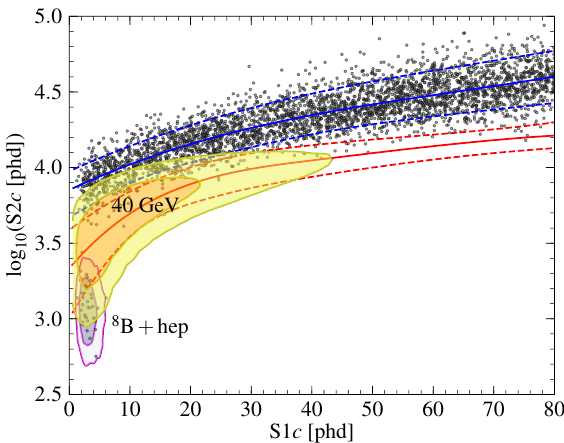
Figure 6. Scatter plot of an example data set of simulated events from background in 1000 live days and a 5.6 tonne fiducial mass. ER and NR bands are indicated in blue and red, respectively (solid: mean value; dashed: areas for 10% and 90% populations). The 1 σ and 2 σ contours for low-energy NRs from 8 B and hep solar neutrinos, and a 40 GeV/c 2 WIMP are shown as shaded regions [4].